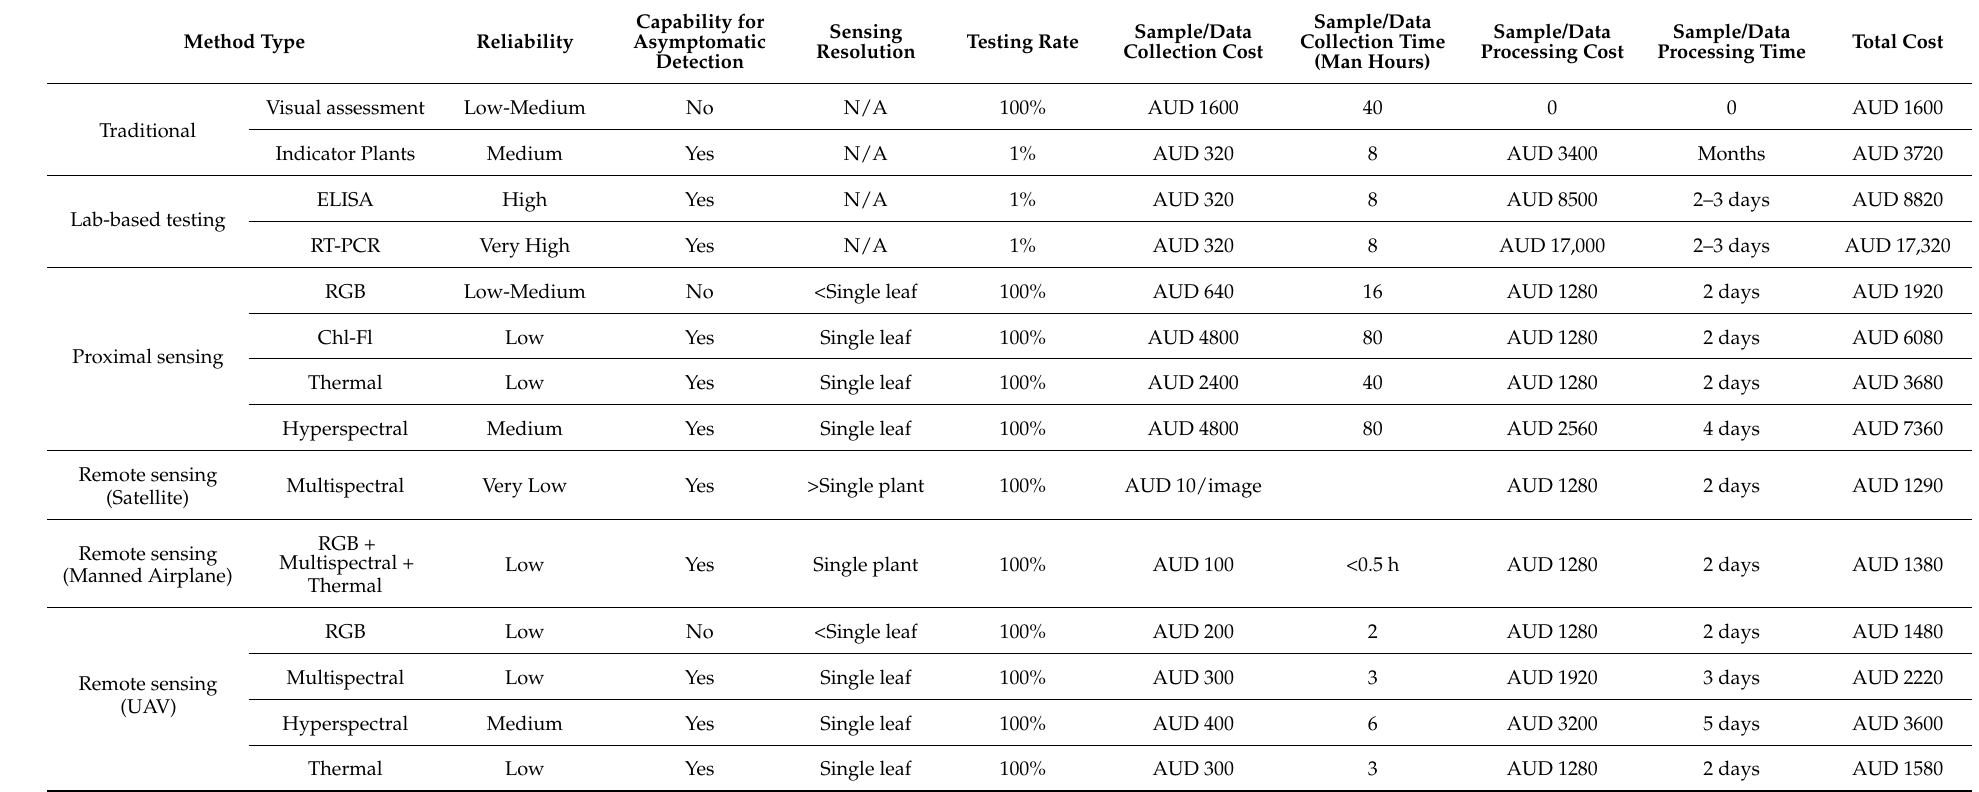
Table 2. Cost comparison between detection methods based on a typical Australian